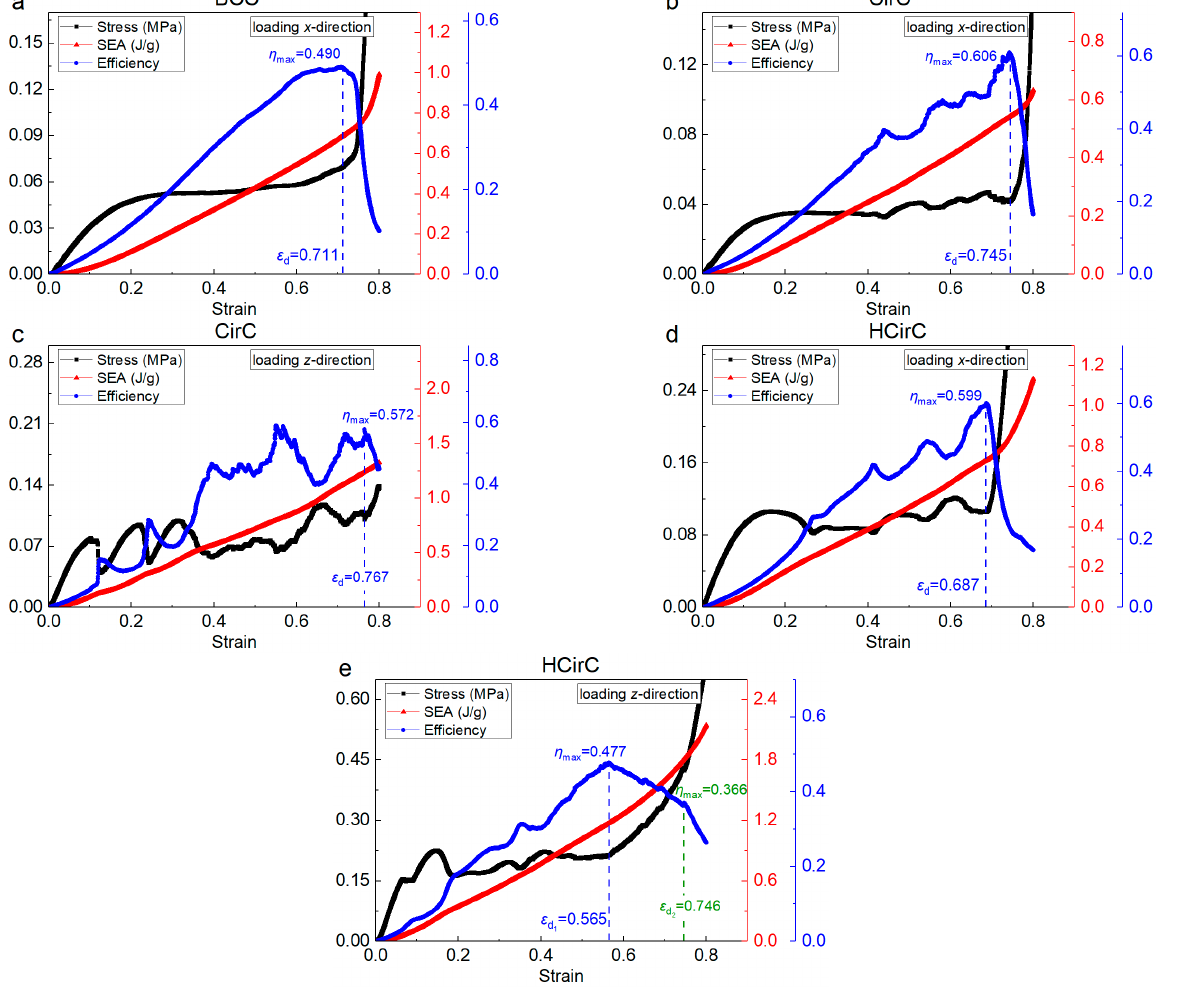
Figure 17. The comparison of compression stress, energy efficiency, and SEA curves along different compression directions: in ( a ) for BCC; in ( b ) and ( c ) for CirC; in ( d ) and ( e ) for HCirC.